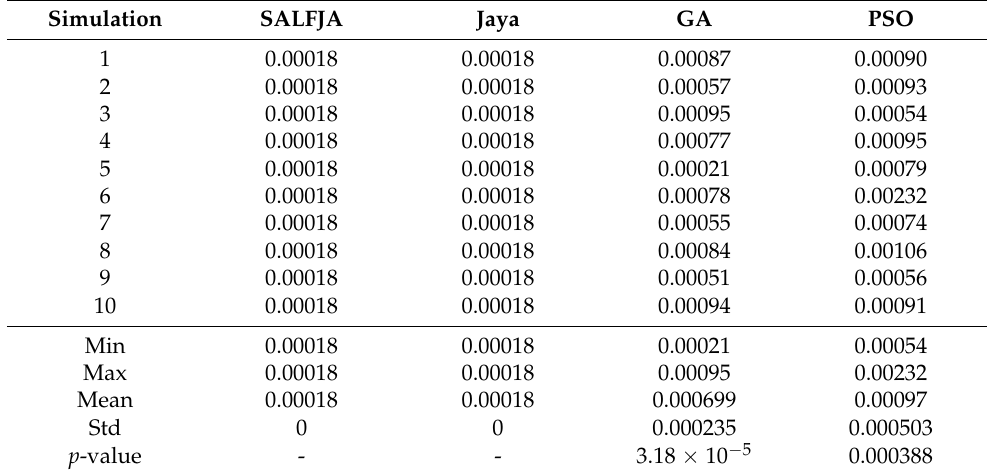
Table 3. Stochastic validation of proposed SALFJA algorithm for DG